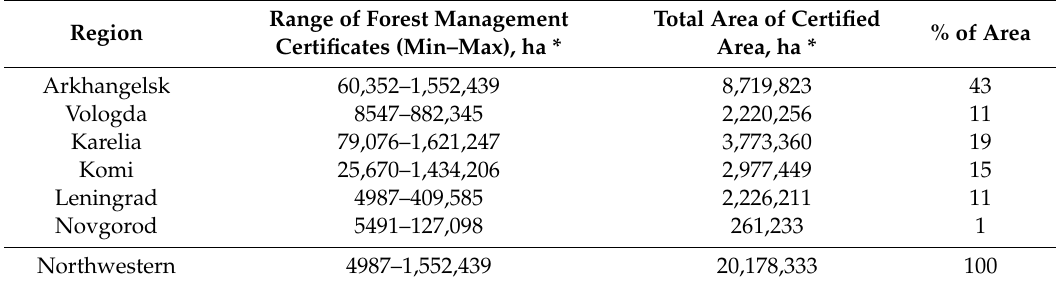
Table 3. Certified area by the region and range of Forest Stewardship Council (FSC) certificates. Region